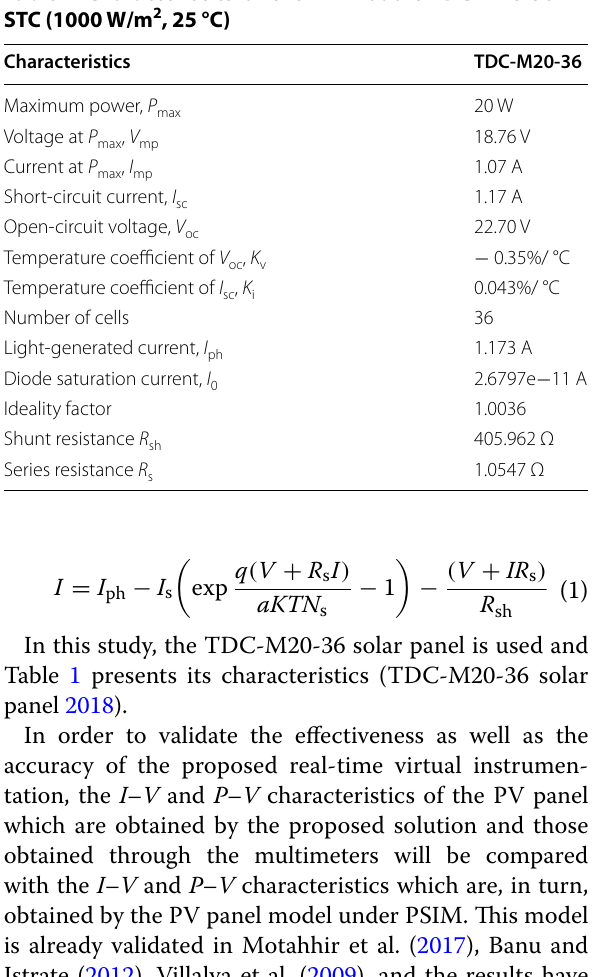
Table 1 Characteristics of the PV Module TDC-M20-36